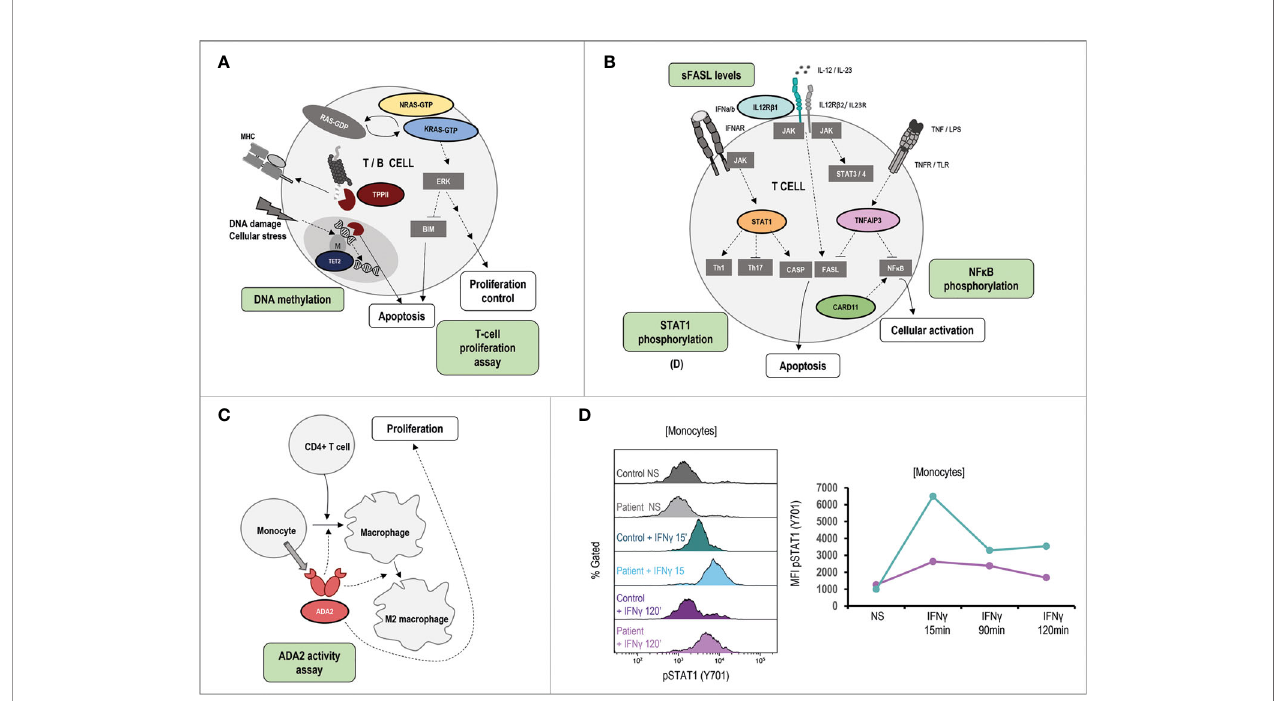
FIGURE 6 | Pathophysiology and functional assays in other ALPS-like related genes. Immunologic studies are outlined in green. It is shown schematic representation of the genetic defects and pathways identi fi ed in ALPS-like patients with RALD, TTP2 and TET2 disorders (A) , IL12RB1, STAT1 GOF, TNFAIP3, CARD11 GOF (B) , ADA2 (C) . (D) Hyperphosphorylation and delayed dephosphorylation of STAT1 (in tyrosine 701) induced by IFN g in patient´s monocytes with gain of function of STAT1 in comparison of the healthy control included. Line graph shows the MFI of STAT1 phosphorylated in the STAT1 GOF patient (blue) and the healthy control (purple). NS, no stimulation.